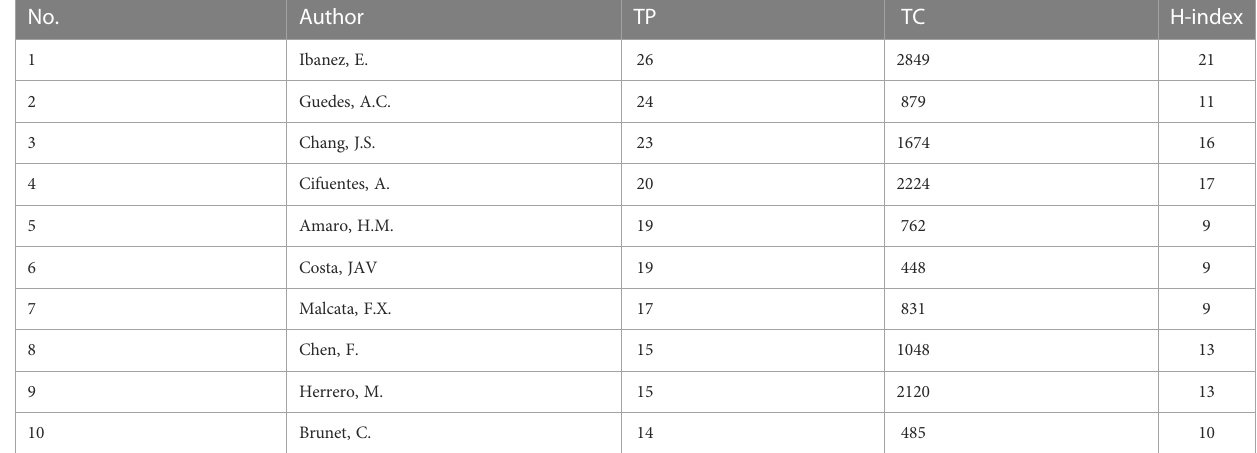
TABLE 2 Top 10 authors with the most publications in microalgae antioxidant studies (based on TP).